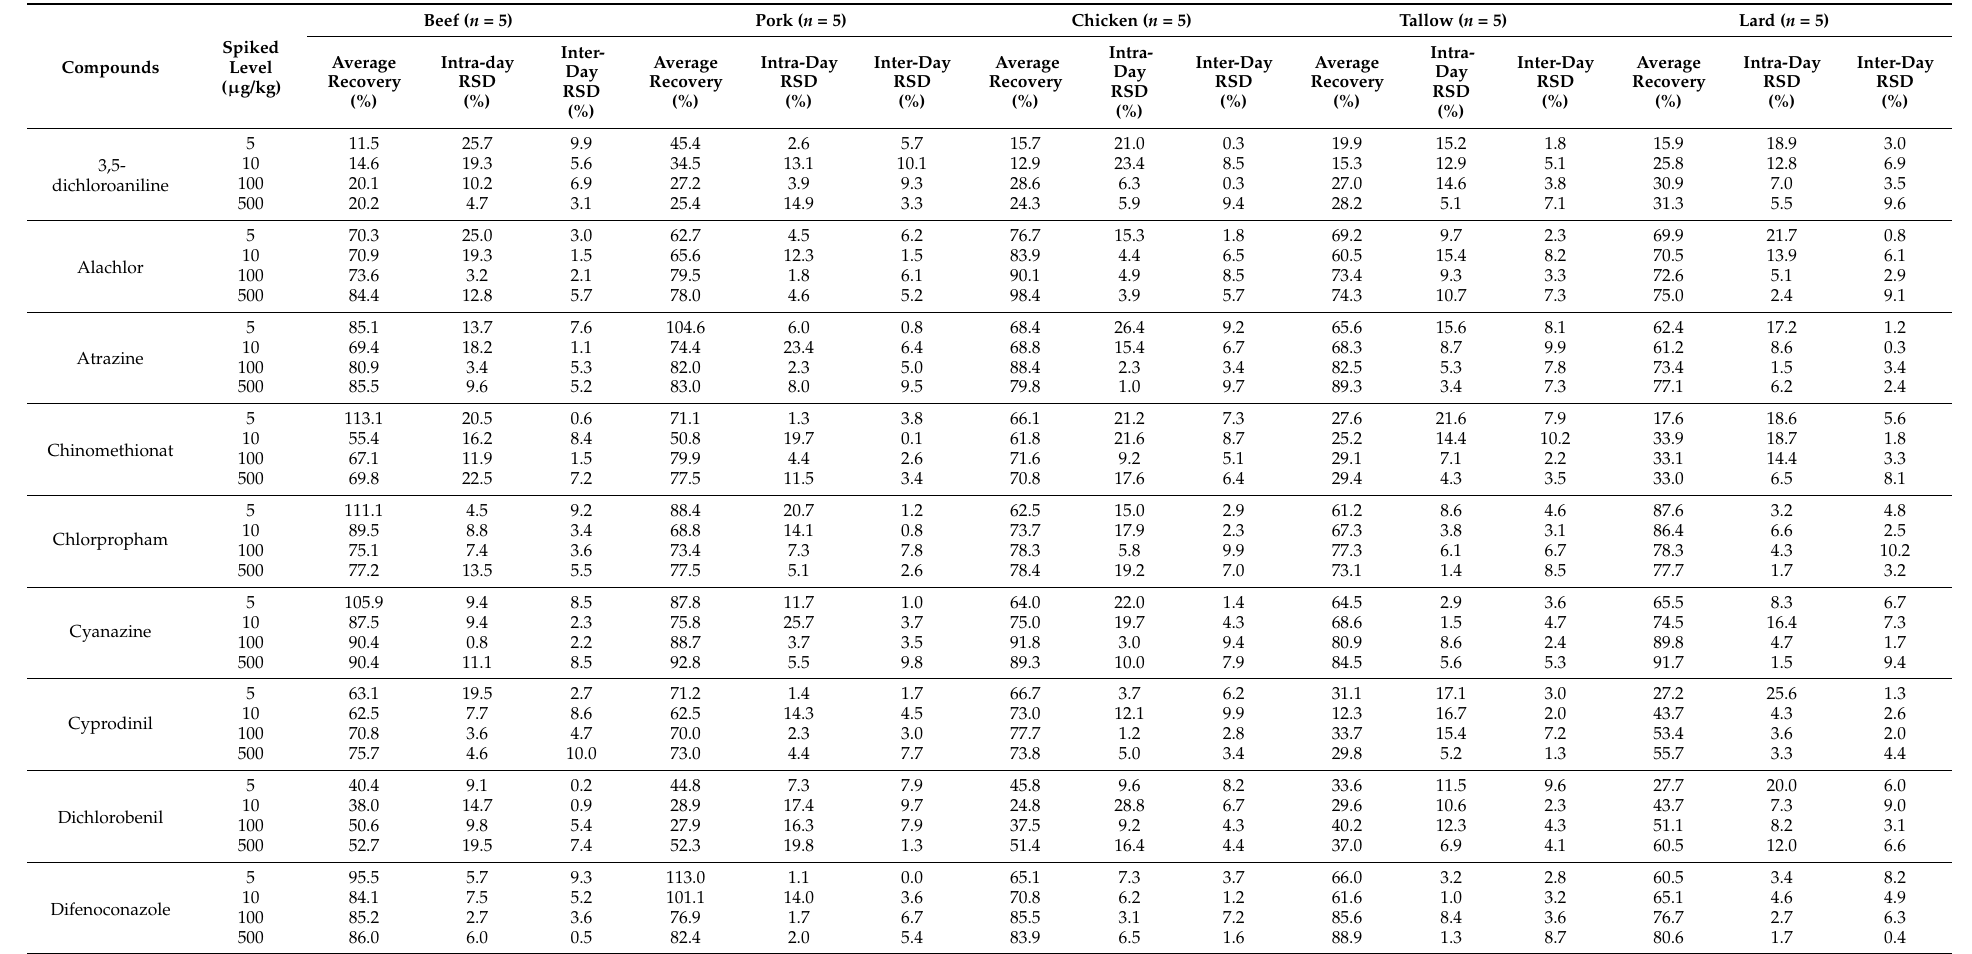
Table A3. Average recovery, inter-day precision, and intra-day precision of the 32 compounds in the beef, pork, chicken, tallow and lard samples.